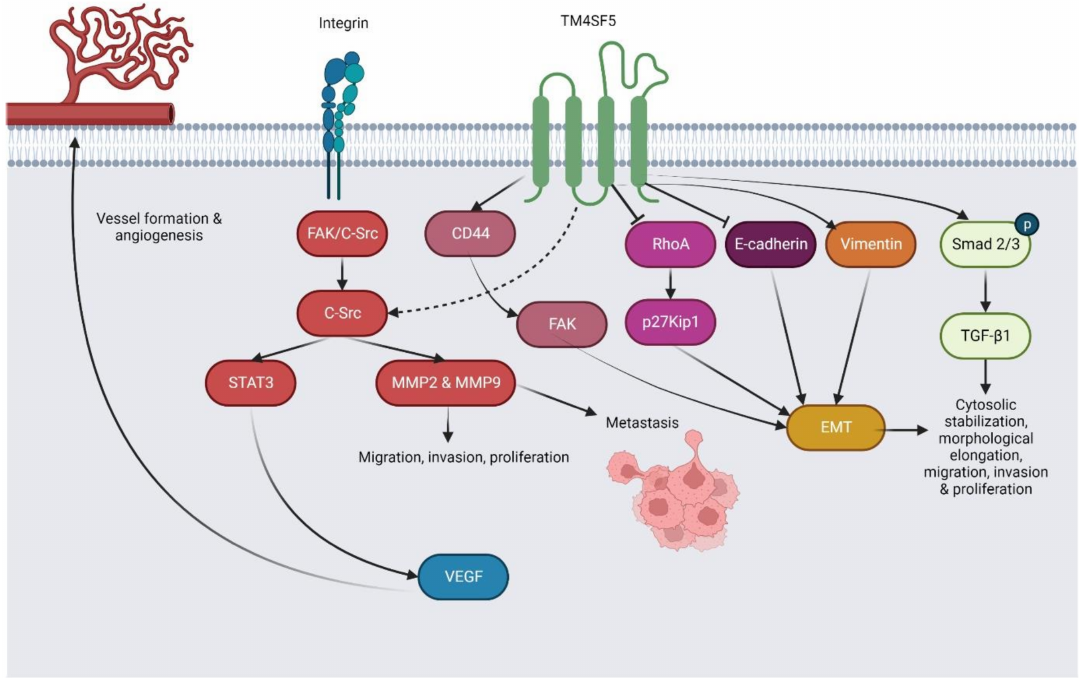
Figure 4. The proposed mechanism underlying the roles of TM4SF5 toward cancer phenotypes and